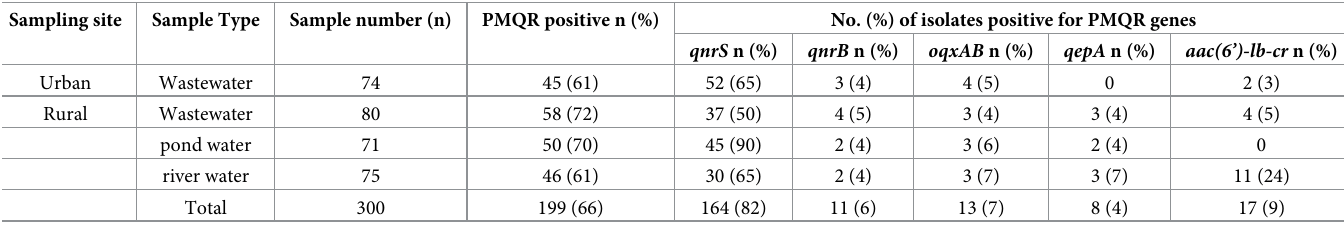
Table 2. Prevalence of PMQR genes in E . coli isolates obtained from different aquatic environments. Sampling